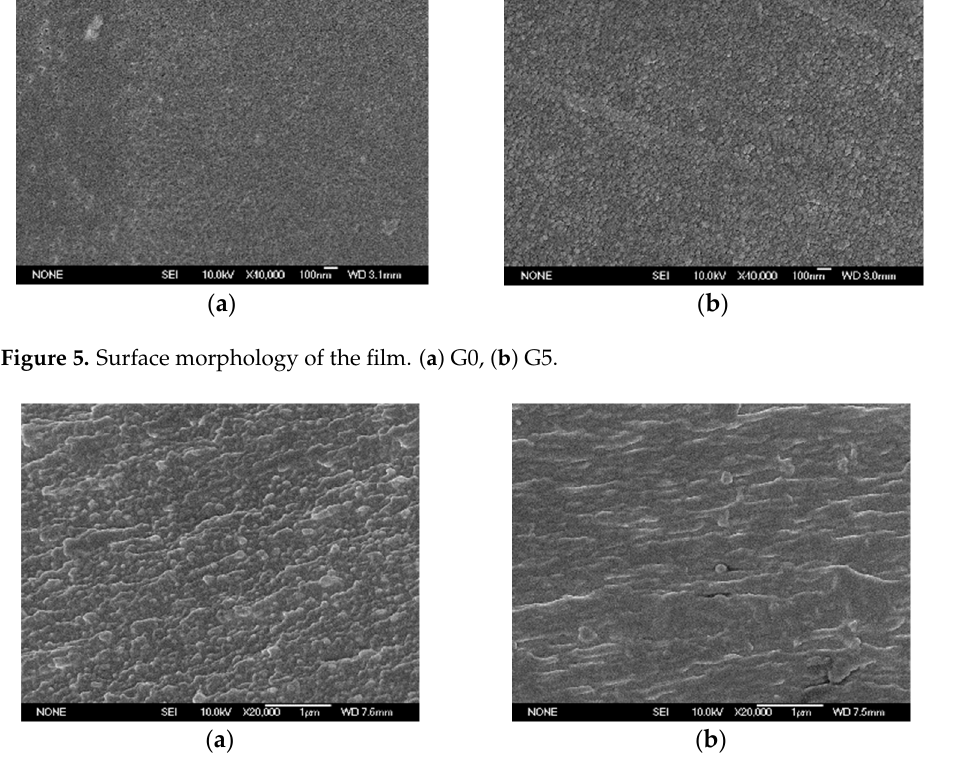
Figure 6. Cross-sectional morphology of the film. ( a ) G0, ( b ) G5.